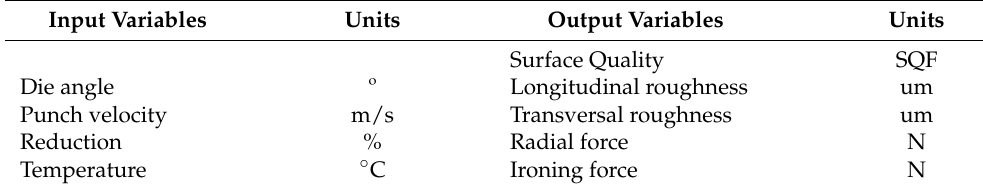
Table 1. Input and output variables of the ANN.